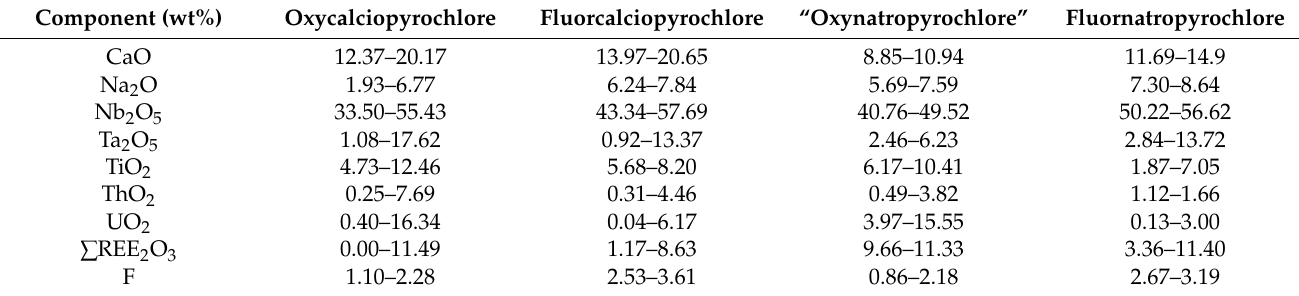
Table 1. The chemical composition characteristics for the pyrochlore group minerals from the syenitic dikes in the Huili area.